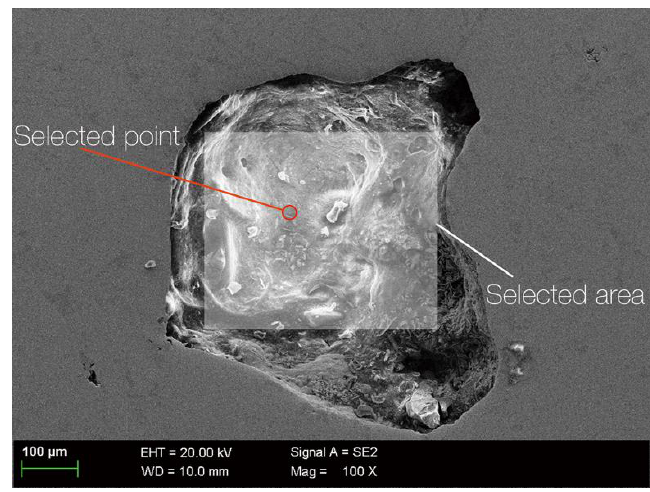
Table 3. The composition of the studied specimens by SEM with EDS.